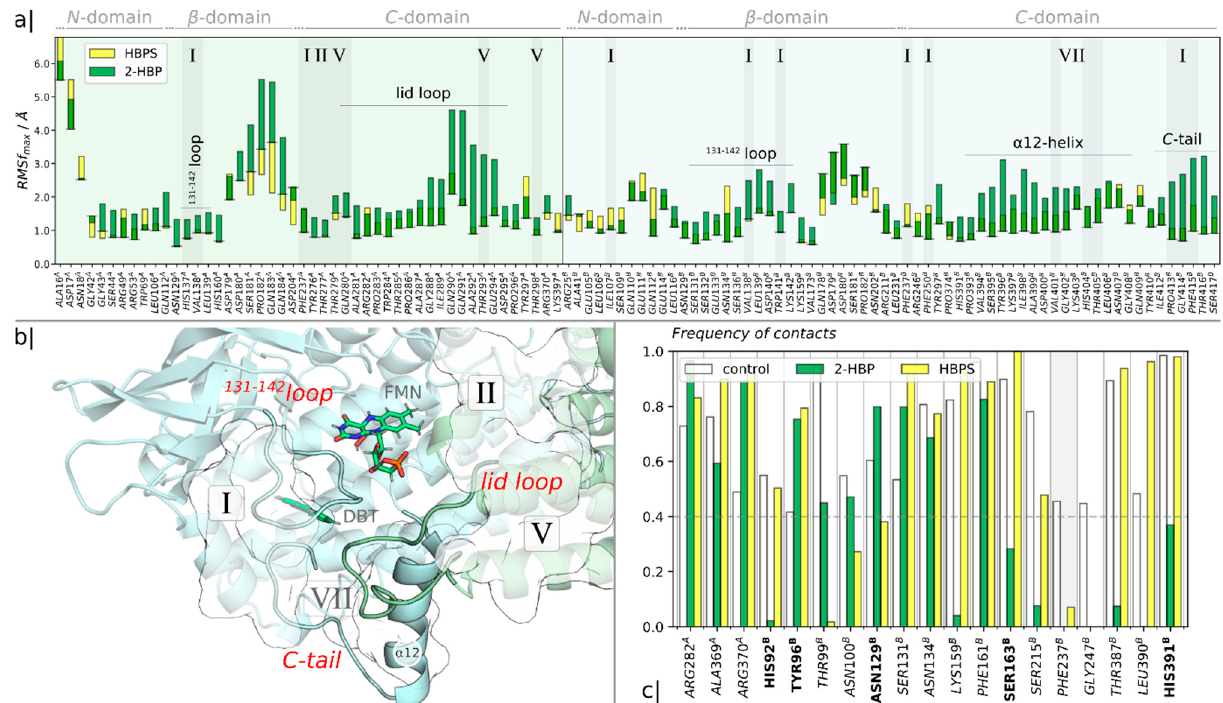
Figure 7. ( a ) Bar plot of the maximum RMSf registered for the simulations where the best-ranked binding sites (V, II, VII, and I) were occupied by either 2-HBP or HBPS; the RMSf values from the simulation with no 2-HBP and HBPS were used as a reference height for each bar, and only residues with an RMSf variation above 0.5 Å in at least one simulation were represented. ( b ) Representation of the elements with the highest increase in RMSf upon occupation of the binding sites V, II, VII, or I: the lid loop, the 131–142 loop, the 410–417 C-tail, and the α 12-helix; the binding sites V, II, VII, and I are represented in surface representation; and the FMN cofactor and DBT substrate are represented in stick representation. ( c ) Bar plot representing the frequency of contacts between the FMN cofactor and the DBT substrate, and DszC residues within 3 Å for the simulations where binding sites I and VII were the most occupied by 2-HBP or HBPS; only residues with a frequency of contacts higher than 40% are represented and the vital active sites residues identi fi ed by Barbosa et al. [29] are highlighted in bold.